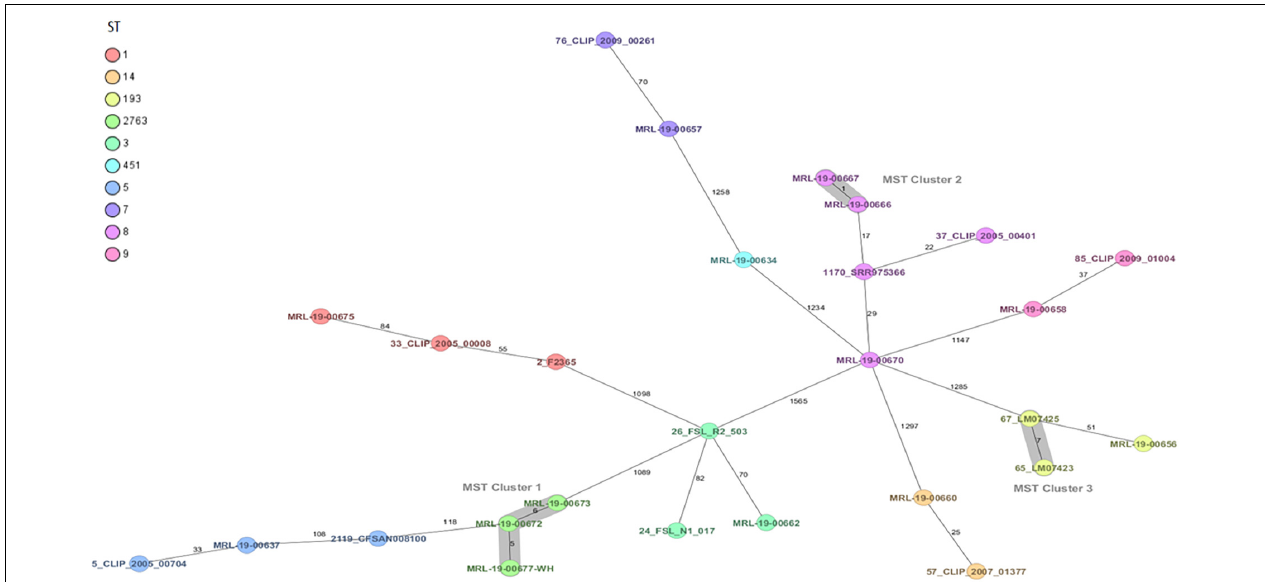
FIGURE 1 | Minimum spanning tree (MST) of 14 Listeria monocytogenes strains from ready-to-eat foods isolated in Chile. L. monocytogenes strains with ST1, ST3, ST5, ST7, ST8, ST9, ST14, ST193, ST451, and ST2763 are of clinical and food origin. Calculation of the MST is based on the defined core genome multilocus sequence typing (cgMLST) scheme consisting of 1,701 target genes from Task templates for SeqSphere+ v. 7.8.0 (2021-7). Isolates are represented as colored circles according to the classical MLST. Black numbers are in accordance with the allelic difference between isolates. Isolates with closely related genotypes are marked as